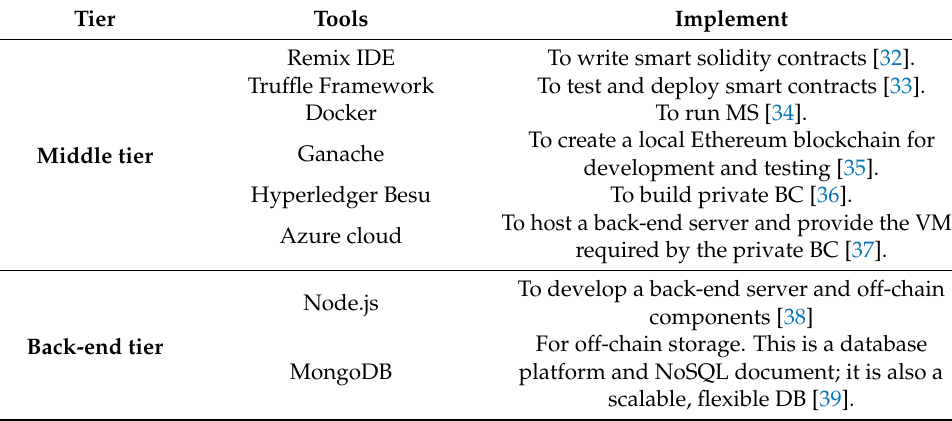
Figure 7. Three-tiered architecture. Table 2. Development Tools